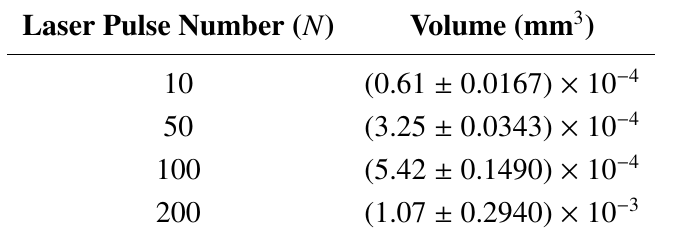
Table 1. Measurement of crater volume on an irradiated silver target. Data were fitted to the N , M is the total mass removed; the mass and number of silver atoms linear relation: M = m p = 60.0 ng and N = 3.35 × 10 14 atoms, respectively. ablated per single pulse are: m p at